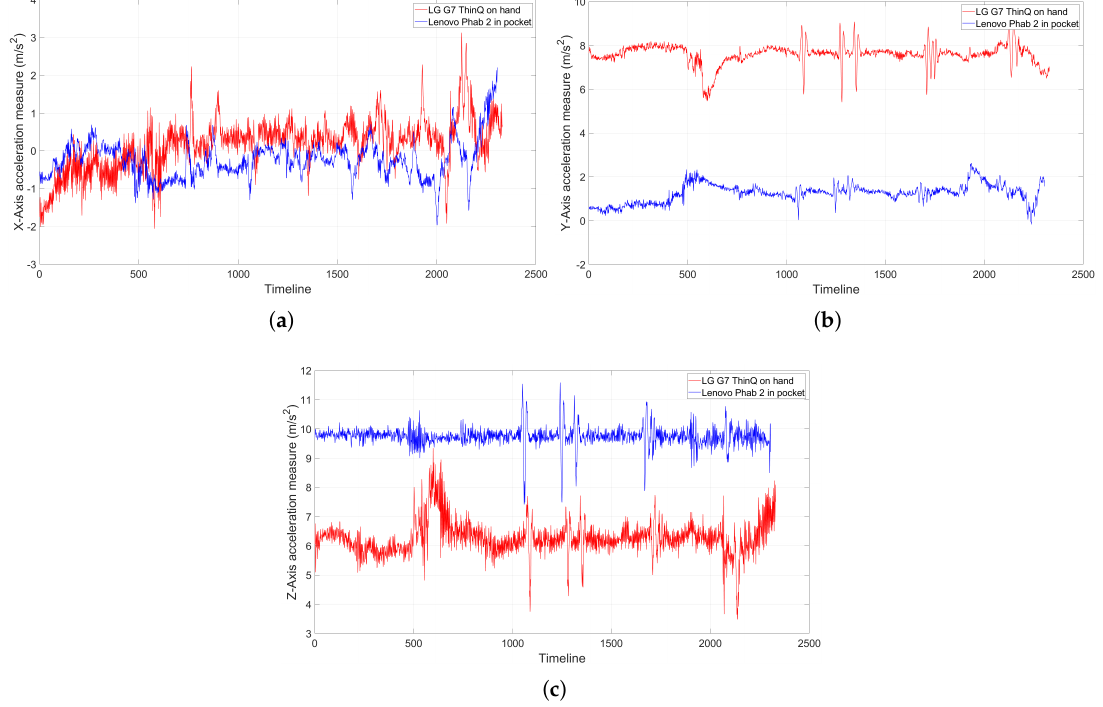
Figure 5. The accelerometer measures of individual axes of two phones in the same position yet with different placements over the same trip: Their measures may vary significantly. ( a ) X -axis; ( b ) Y -axis; and ( c ) Z